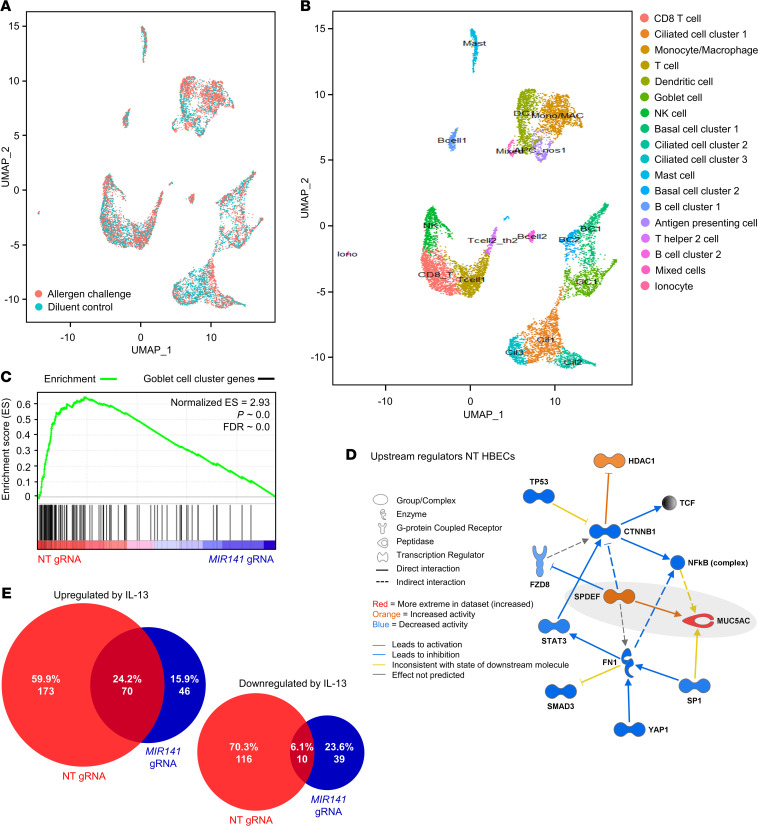
MIR141 targeting interferes with IL-13 signaling and results in reduced expression of goblet cell genes.Single cell RNA sequencing analysis of bronchial epithelial brushings obtained from allergic asthmatic subjects 24 hours after segmental allergen challenge (n = 4) or diluent control (n = 4). (A) Overlay of cellular clusters from allergen challenge and diluent control. (B) Eighteen identified cellular gene clusters with annotations. (C) Gene set enrichment analysis of 100 goblet cell cluster genes (Supplemental Table 3) in human bronchial epithelial cells (HBECs) that have undergone gene editing with nontargeting (NT) or MIR141 gRNAs, subsequently grown at air-liquid-interface with IL-13 stimulation (n = 4/group). (D) Upstream regulator SPDEF (P = 2.5 × 10–12) identified by Ingenuity Pathway Analysis (IPA) of genes differentially expressed (FDR < 0.1) in NT HBECs following IL-13 stimulation. (E) Overlapping and uniquely expressed genes (IL-13 versus untreated) in NT and MIR141 gRNA HBEC cultures (n = 3–4/group) assessed by RNA sequencing (χ2 test; ****P < 0.0001).